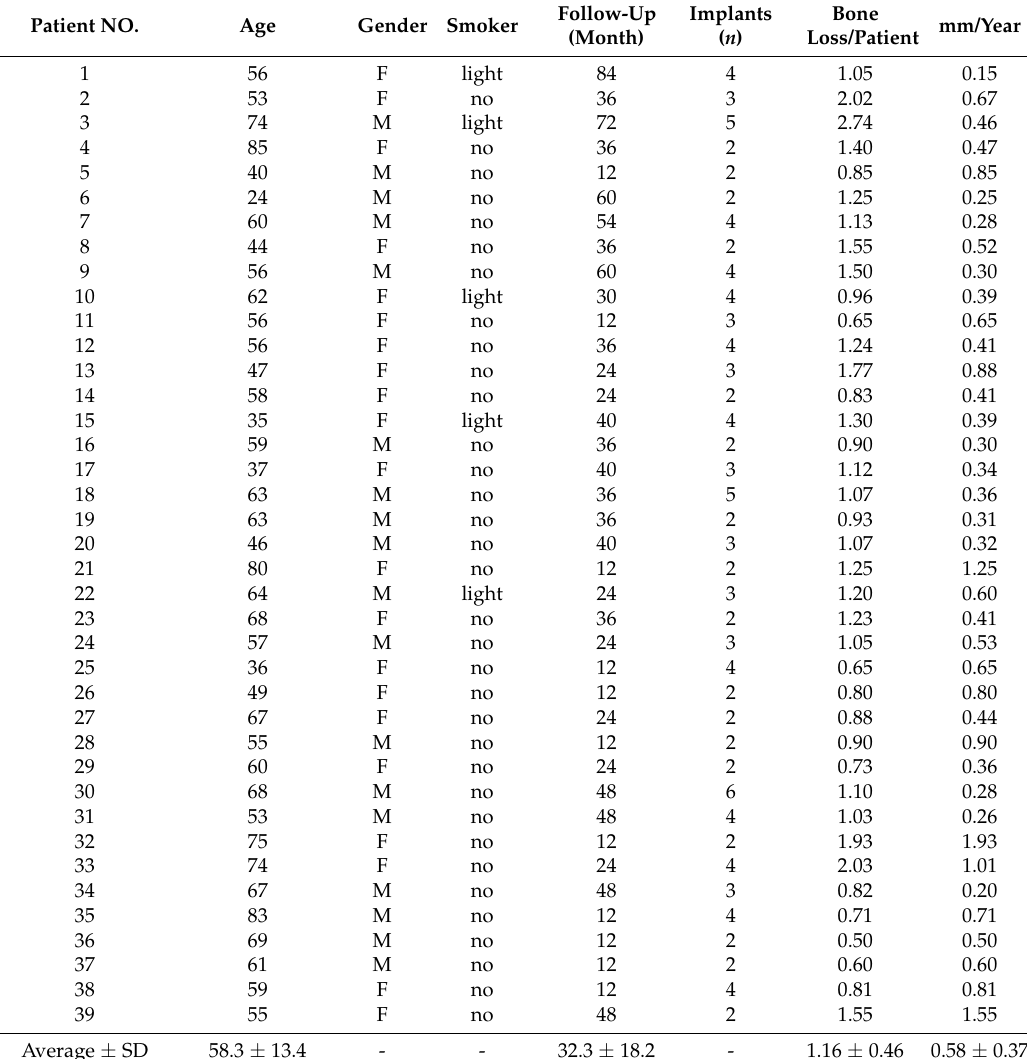
Table 3. Marginal bone loss in 39 patients (118